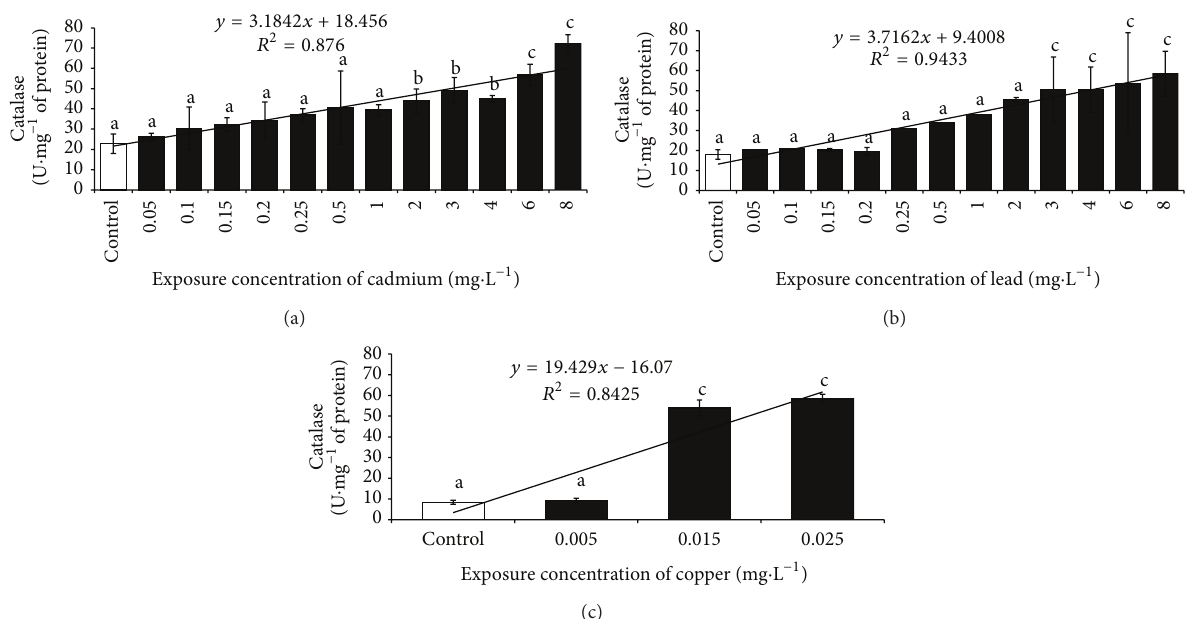
Figure 2: Mean ( ± SD) variation of catalase activity in Perna perna of control and Cd-exposed (a), Pb-exposed (b), and Cu-exposed mussels (c) after 72 h exposure. Values followed by the same letter are not statistically different ( 𝑃 > 0.05 ) but values followed by the different letter are statistically significant ( 𝑃 < 0.05